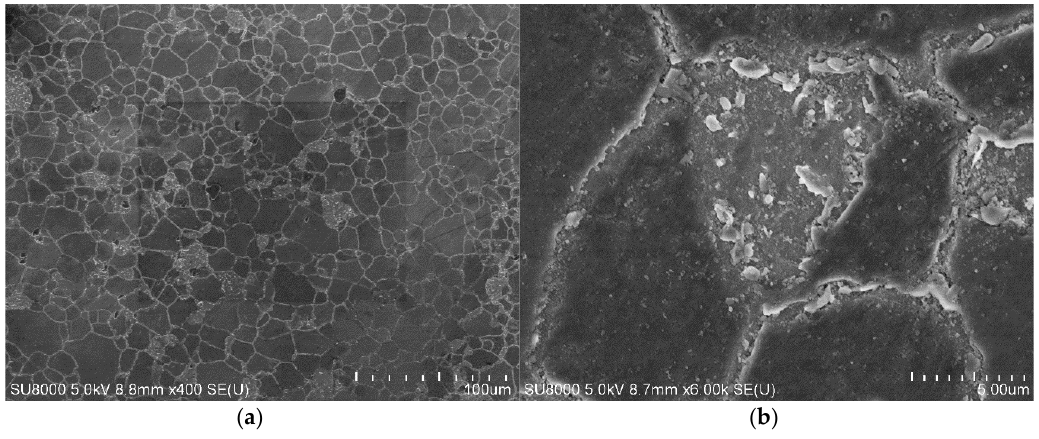
Figure 14. SEM images ( a , b ) of the dendrites on the edge of the as-cast AZ61 magnesium alloy with different magnifications,